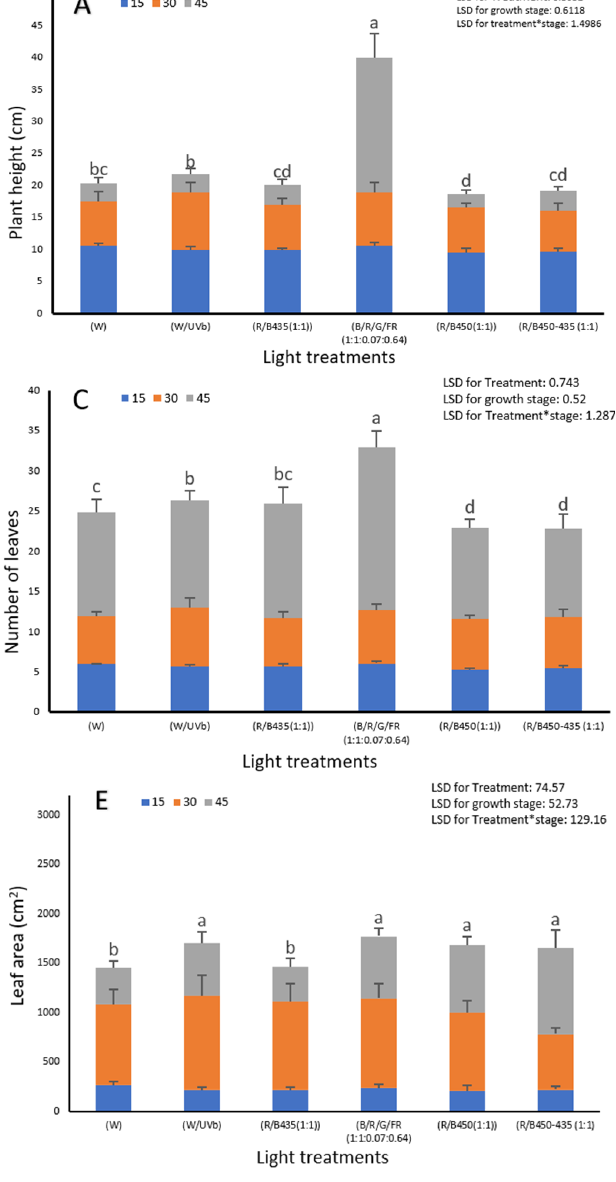
Figure 3. The impact of LED light spectrum on ( A ) plant height (cm); ( B ) plant fresh weight (g); ( C ) number of leaves; ( D ) plant fresh weight (g); ( E ) leaf area (cm 2 ) and ( F ) stalk height (cm) of Carmoli variety (red lettuce) at three developmental stages, 15, 30 and 45 days from transplanting in the plant factory. Letters indicate significant differences ( p <0.05) between treatments in each experiment.